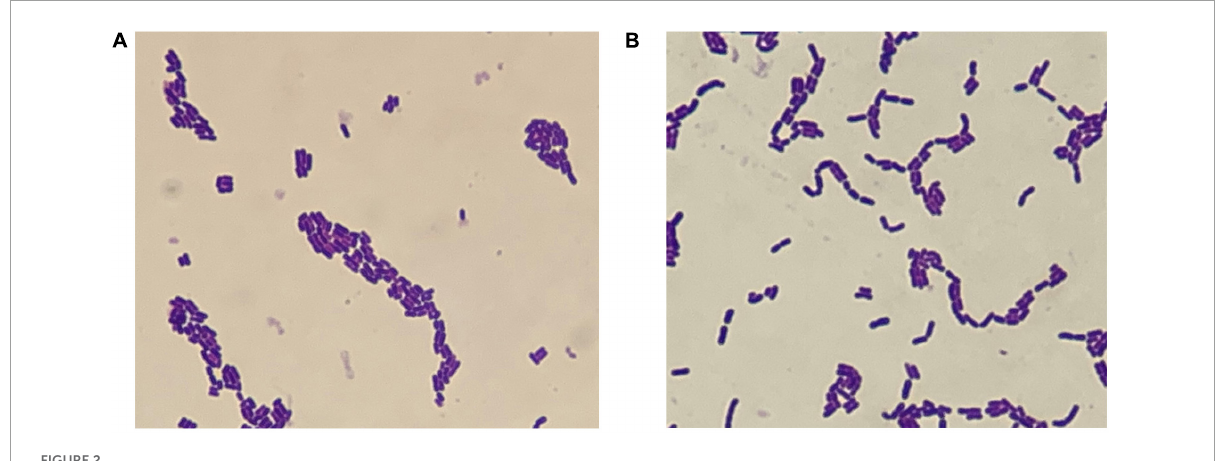
FIGURE2 Micromorphology of WFC 414 (A) and WFC 502 (B) .